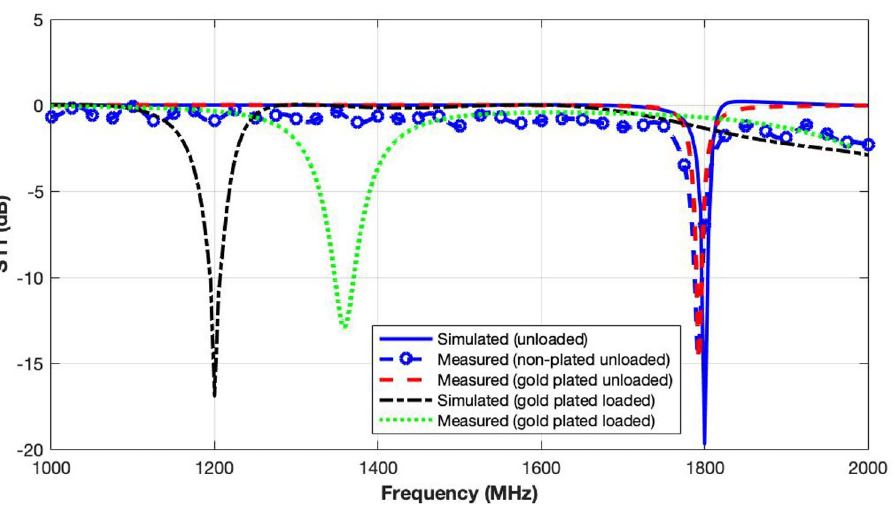
Figure 11. Reflection coefficient measurements of the exposure system comparing the simulated and measured reflection coefficients for non-plated and gold-plated unloaded and loaded (with 12 ml of cell culture)